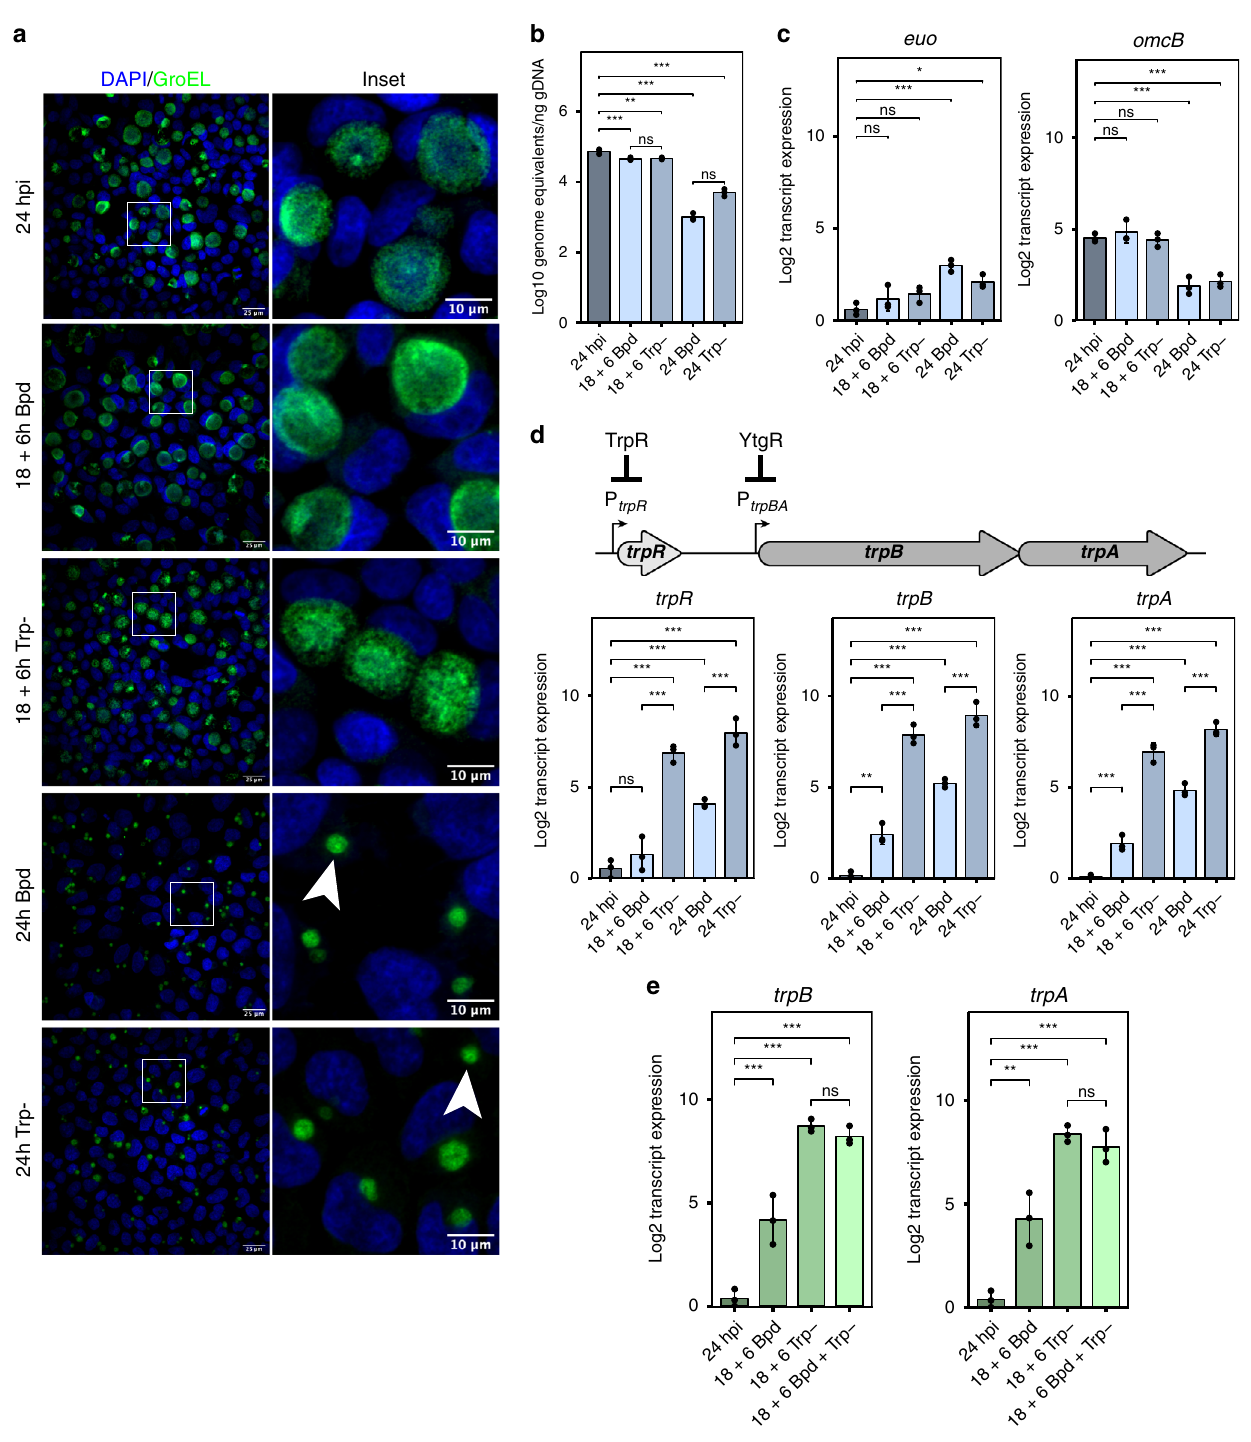
Fig. 1 Tryptophan limitation overcomes iron-dependent repression of trpBA . a Representative ( N = 3) immuno fl uorescent confocal micrographs of chlamydial morphology in HeLa 229 cells infected with C. trachomatis serovar L2 (434/Bu) (MOI 2) starved for iron by 100 µ M 2,2-bipyridyl